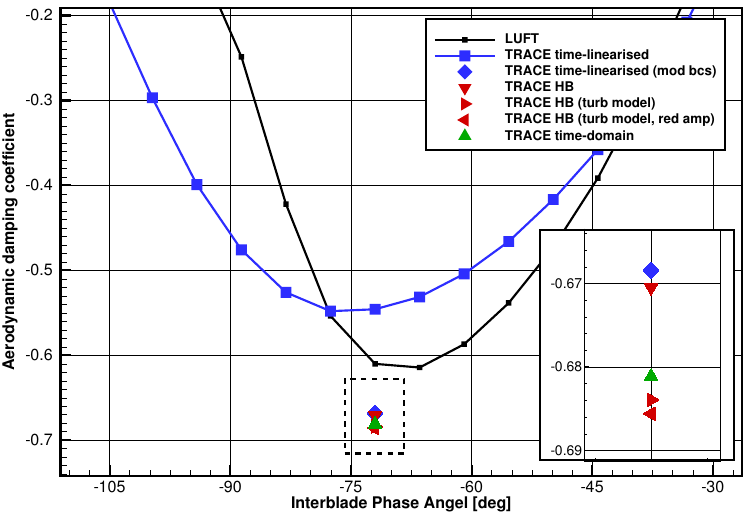
Figure 7. Aerodynamic work coefficient predicted by different harmonic balance set-ups σ = − 72 ◦